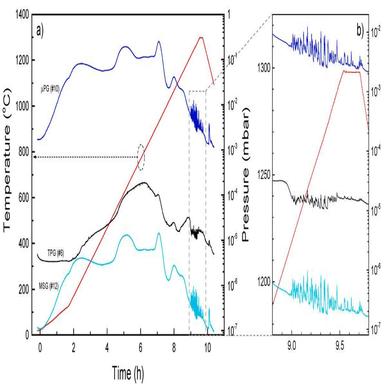
(a) Typical temperature profile (red line, left scale) and pressures (right scale) recorded by the μPG (blue), TPG (black) and MSG (cyan) sensors during an experiment. The numbers in the labels identify the sensors in.